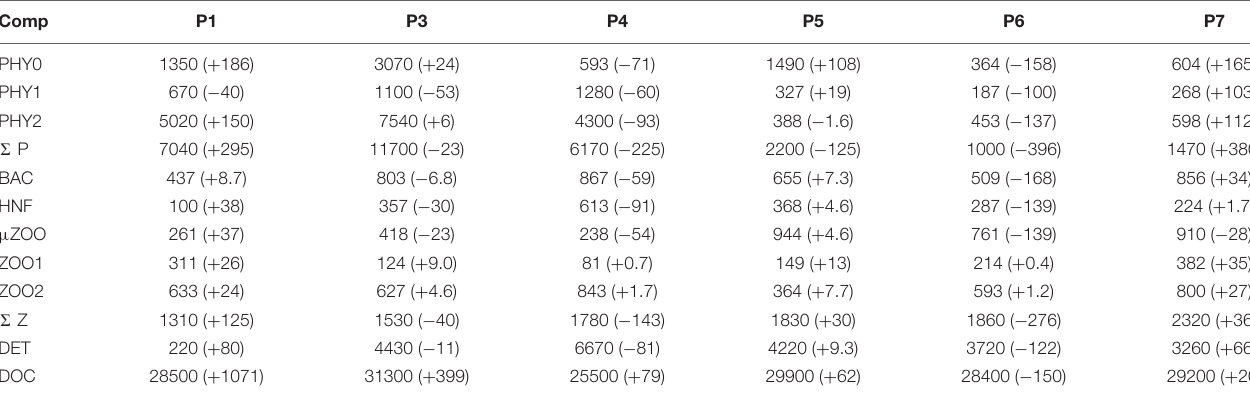
TABLE 2 | Abbreviations of the planktonic food web compartments, the respective stock sizes (mg C m − 2 ) in the upper 40 m water column, and changes of stocks (mg C m − 2 d − 1 ) in stations P1–P7.